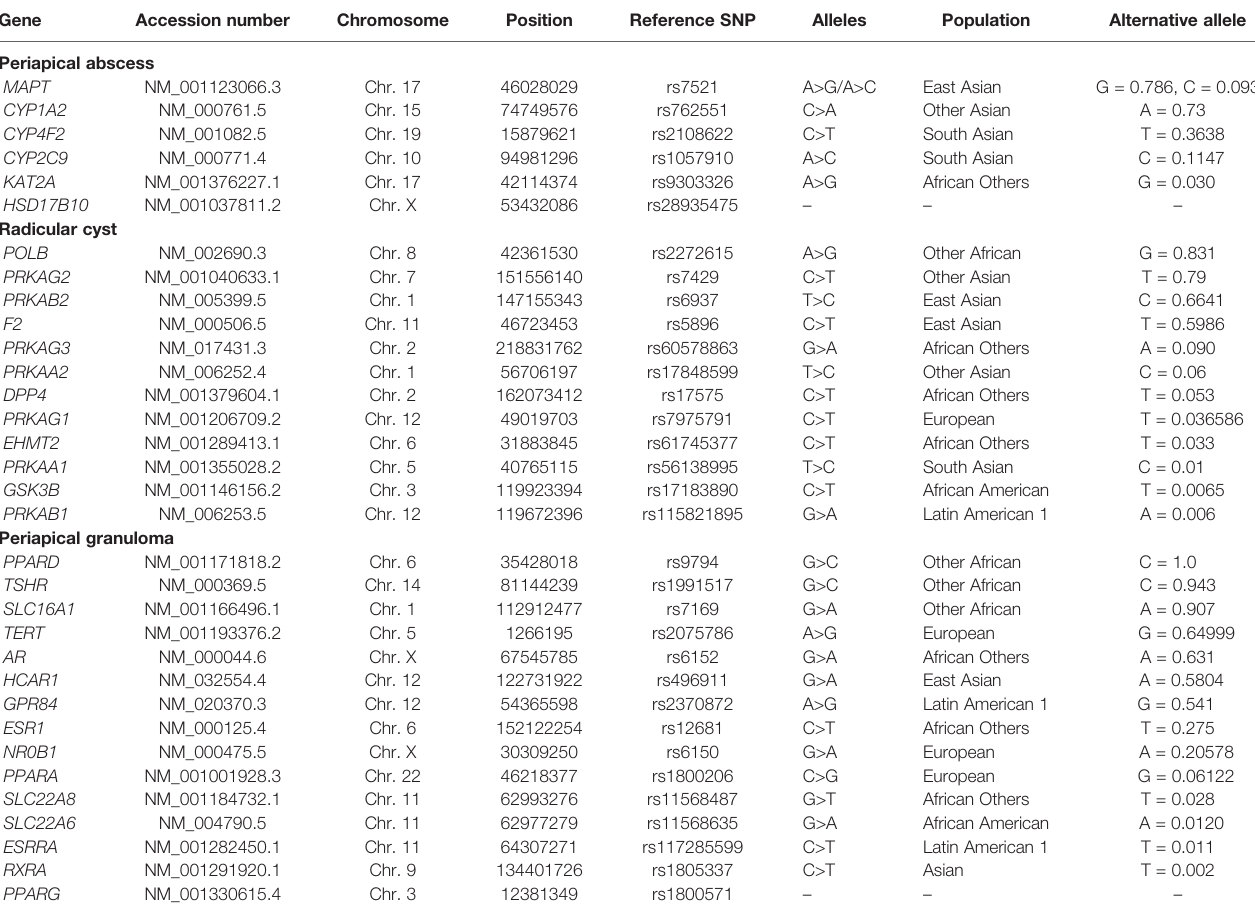
TABLE 2 | The highest distribution of single nucleotide polymorphism in a population of gene-related enrichment pathways of periapical lesions in human genome assembly (GRCh38.p12). Gene Chromosome Reference